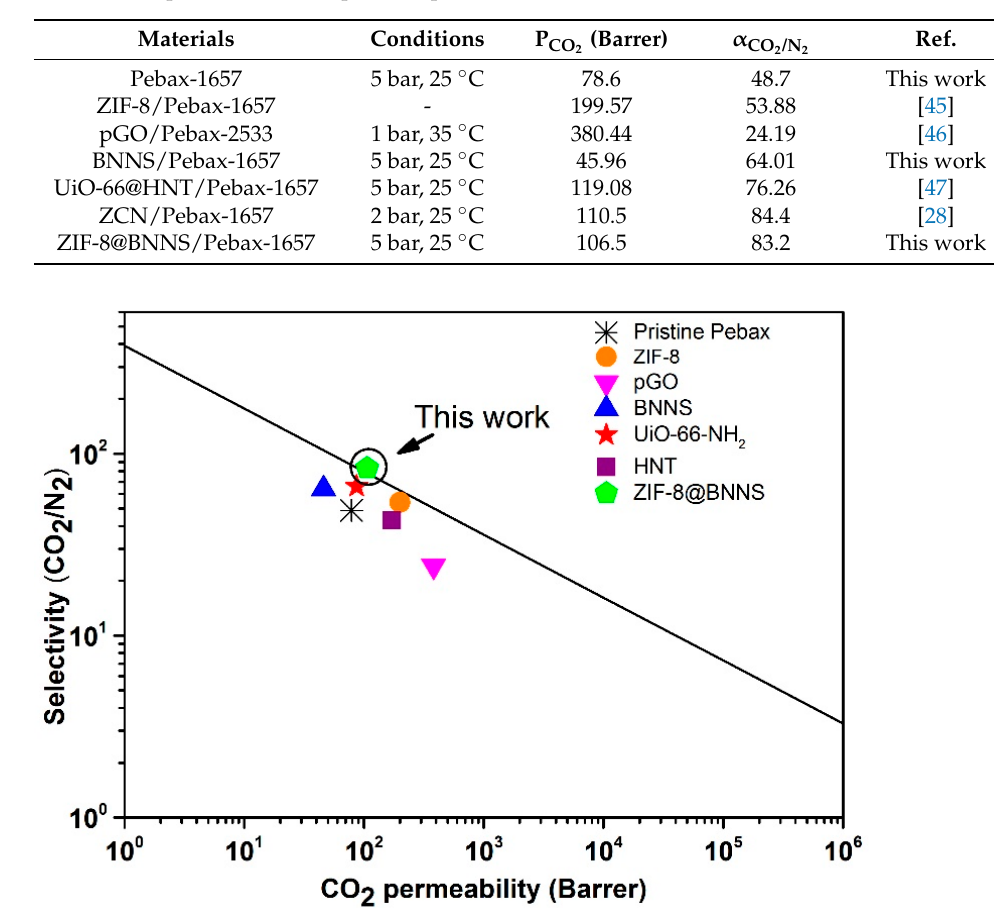
Figure 7. The relationship between the CO 2 permeability and the CO 2 /N 2 selectivity of the MMMs prepared in this work and the